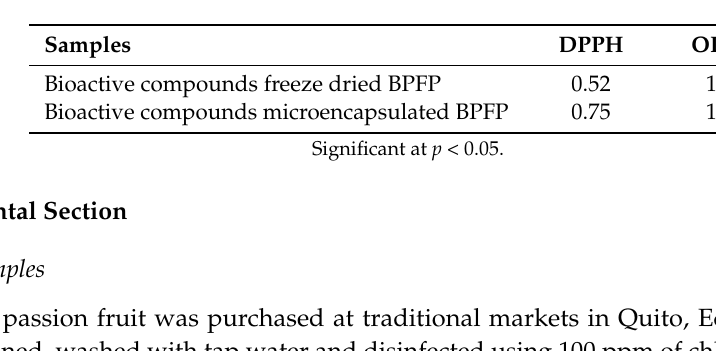
Pearson’s correlation coefficients ( r ) between bioactive compounds (flavonoids